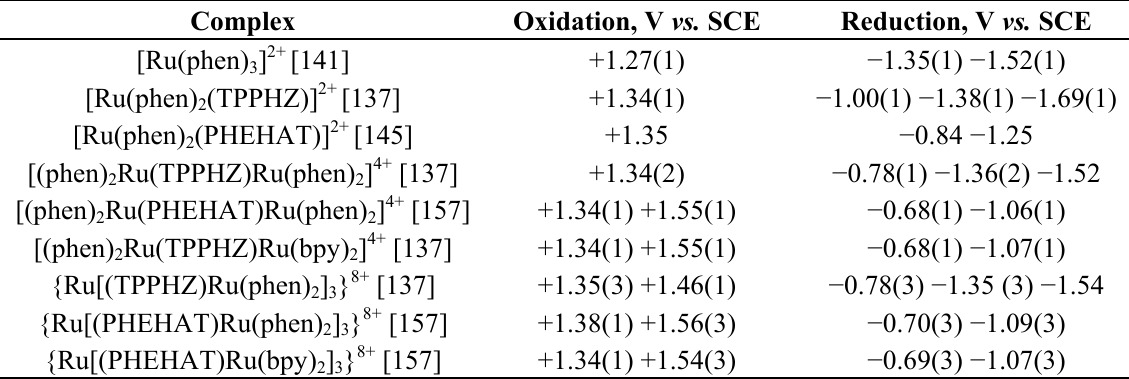
Table 12. Redox potentials measured by cyclic voltammetry in acetonitrile vs. SCE at room temperature, with 0.1M t Bu electrode. In parenthesis is the number of exchanged